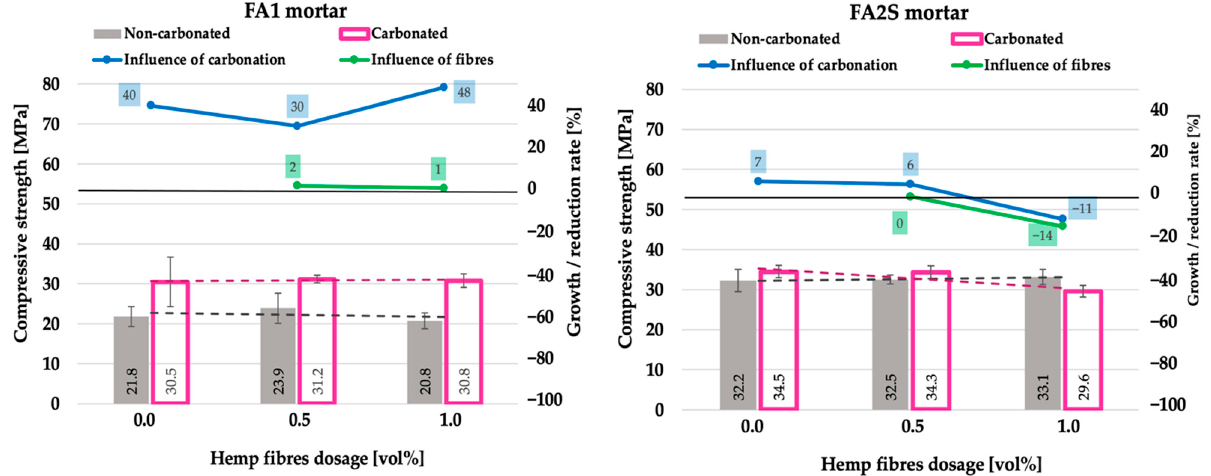
Figure 4. Compressive strength of fly-ash-based (FA1) and fly-ash-and-slag-based (FA2S) mortars prior to [26] and after accelerated carbonation.